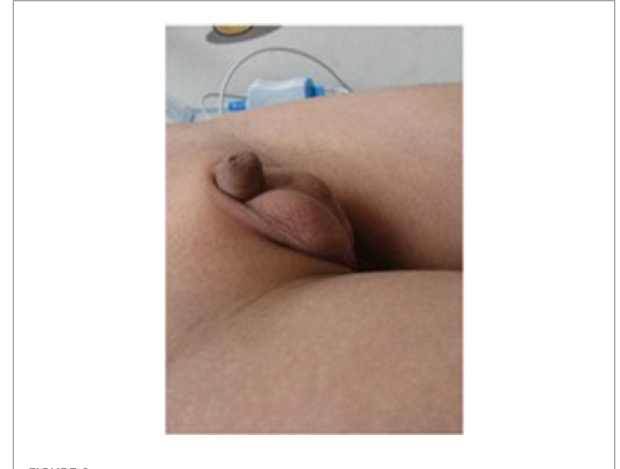
FIGURE 2 The small penis and testicles observed in the patient.